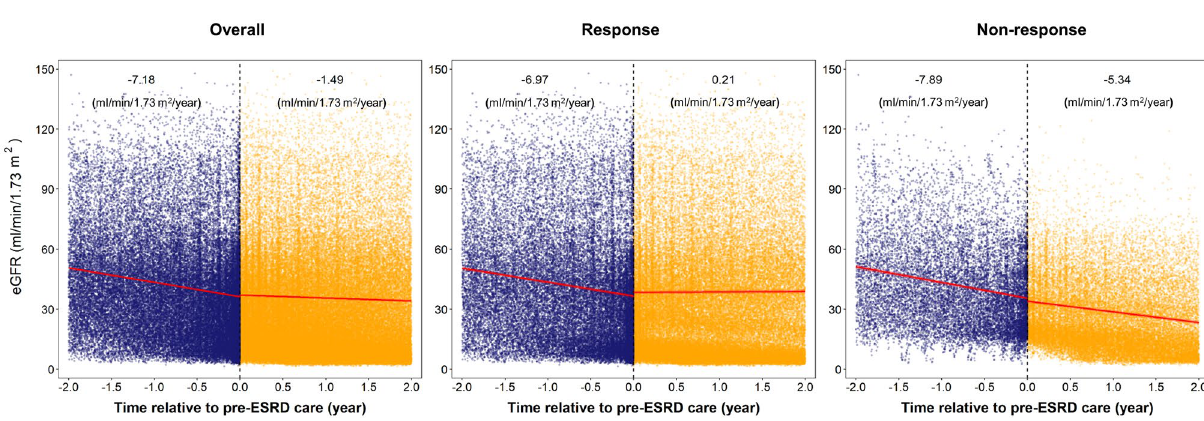
Figure 3. The eGFR slope (red line), with the light red shaded area representing the 95% confidence interval, before and after enrollment of the entire study population into the pre-ESRD program. The eGFR slope was modeled using the growth piecewise linear mixed model through the incorporation of random effects. Blue and orange points represent eGFR measurements before and after enrollment into pre-ESRD program, respectively. The estimated value of eGFR slope (mL/min/1.73 m 2 /y) is